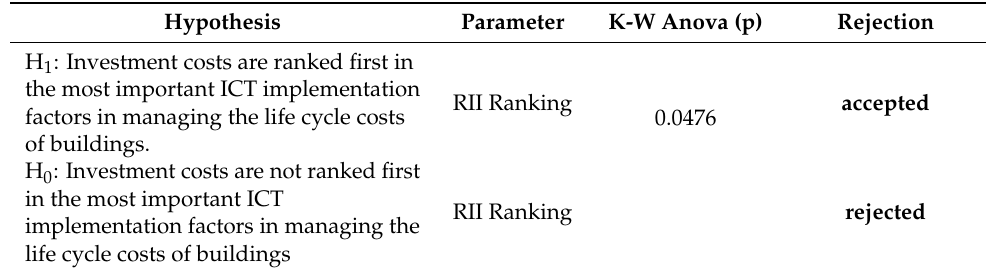
Table 6. Hypothesis results and Kruskal–Wallis ANOVA